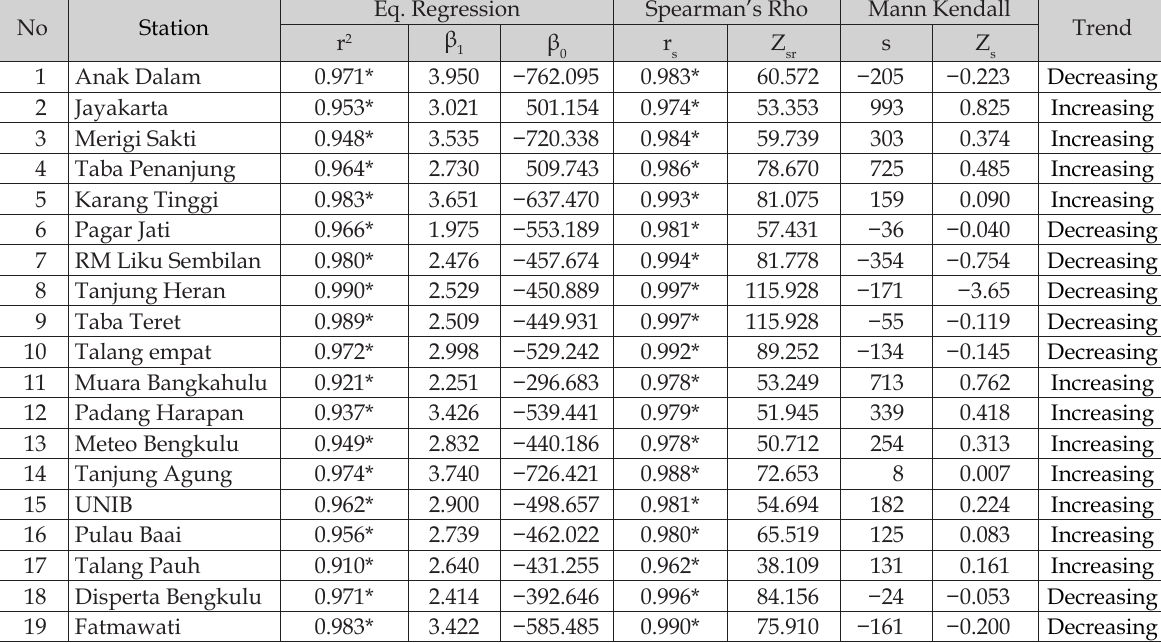
Table 3. Test statistical analysis results for monthly rainfall